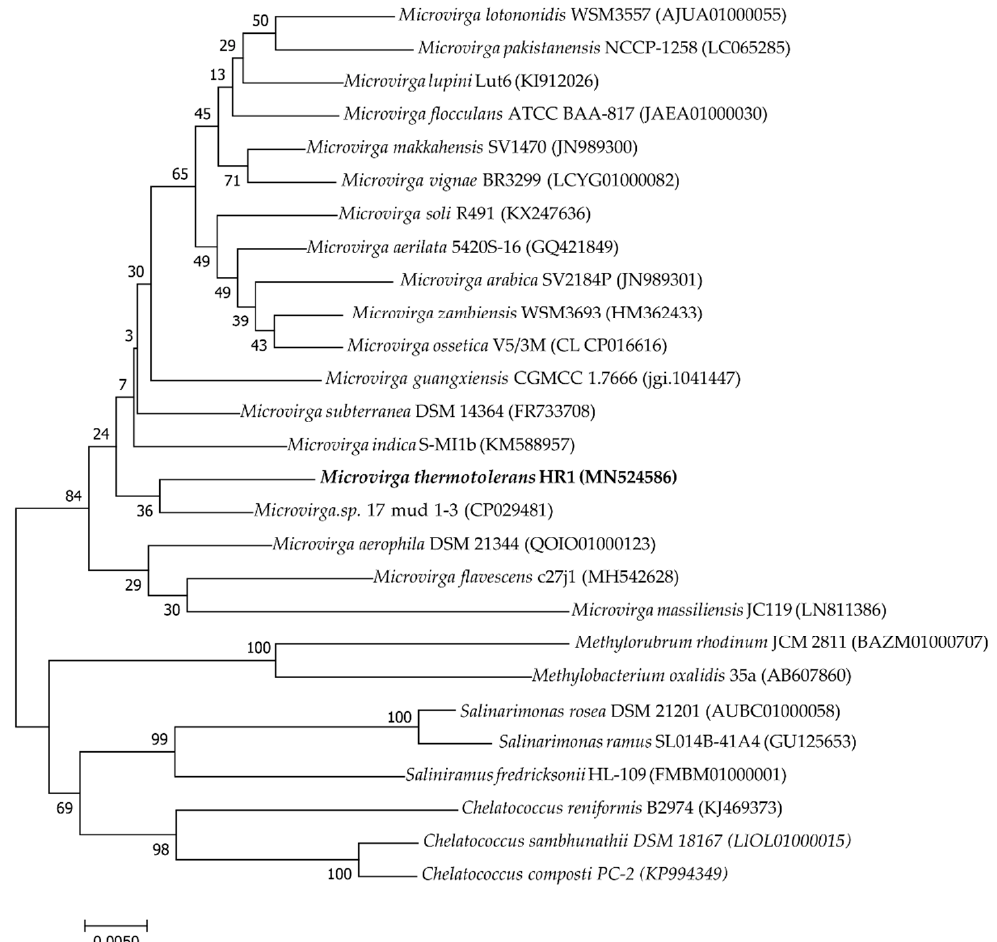
Figure 3. Phylogenetic tree based on 16S rRNA gene sequences reconstructed by the neighbor-joining method. This tree shows the phylogenetic relationship between strain HR1 and closely related species. Bootstrap percentages are based on 1000 replications. The GenBank accession numbers for 16S rRNA gene sequences are shown in parentheses. Bar: 0.005 substitutions per nucleotide position.